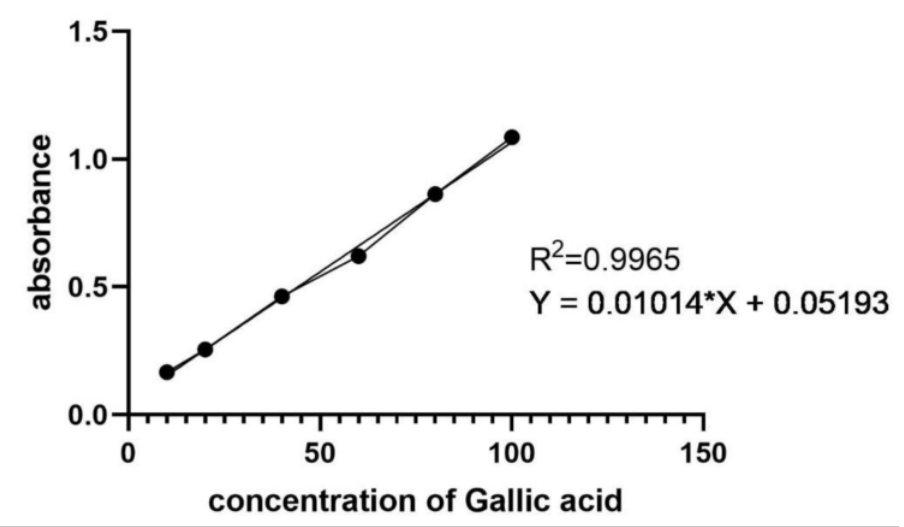
Figure 1. Standard gallic acid standard curve for determination of the total phenolic con-